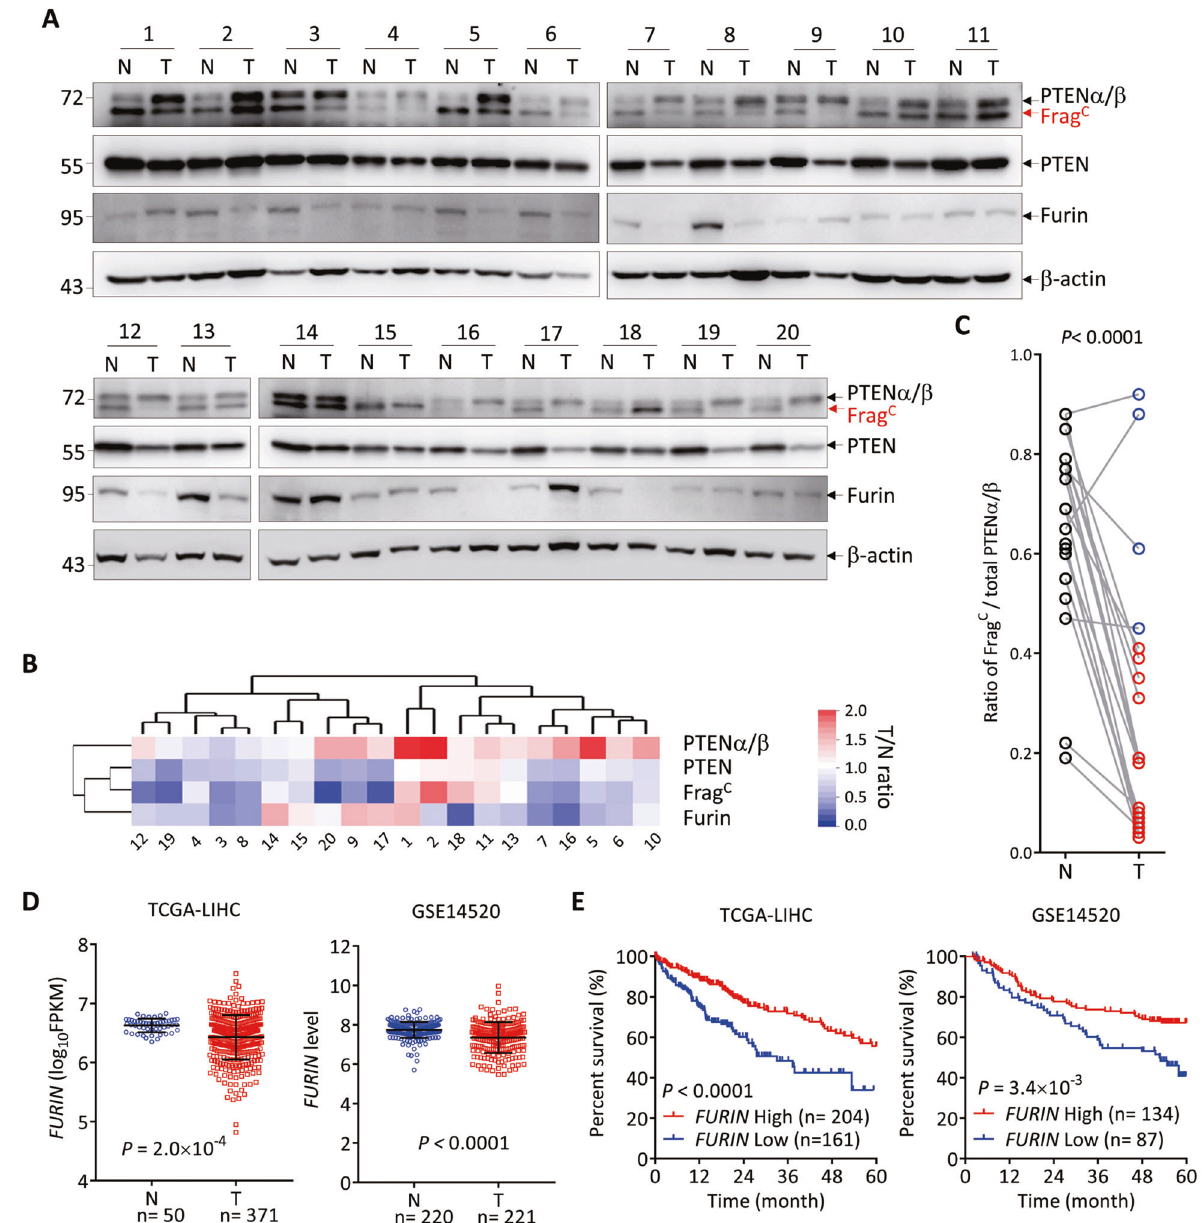
Fig. 6 Cleavage of PTEN α / β is inhibited in liver cancer tissues. A – C 20 liver cancer samples with paired tumor and normal tissues were subjected to Western blot analysis for the indicated proteins ( A ). The intensities of the blot bands were quanti fi ed by Image J, normalized to that of corresponding β -actin, and the T/N ratio of each protein for each patient was calculated and shown as a clustered heatmap ( B ). The ef fi ciency of PTEN α / β cleavage was calculated as the ratio of Frag C versus total PTEN α / β (Frag C + full-length PTEN α / β ) for each sample and compared between the tumor and normal tissue for each patient ( C ). Statistical signi fi cance was determined by two-tailed paired t -test with P values shown. D Scatterplot analysis of FURIN expression between tumor tissues and non-tumor tissues in TCGA LIHC and GEO GSE14520 data sets. Statistical signi fi cance was determined by Mann-Whitney U test (two-sided) with P values shown. E Kaplan-Meier plot of overall 5-year survival of patients with high or low expression of FURIN in the tumor tissues of TCGA LIHC and GEO GSE14520 data sets. Statistical signi fi cance was determined by Log-rank test growth and predicts a better postoperative disease-free survival in formation and progression of various malignancies including colon hepatocellular carcinoma [33]. carcinoma, head and neck cancers, lung, skin and brain tumors By focusing on the NTE-dependent processing of extracellular [31]. However, we found that Furin was downregulated in liver PTEN α / β , this study not only proposes a model that reconciles the cancer tissues compared to paired normal tissues and low FURIN paradoxical roles of extracellular and intracellular PTEN α in tumor- expression predicted poor prognosis of liver cancer patients. In igenesis, but also provides more precise guidelines for therapeutic agreement with our fi ndings, it has been reported that liver- uses of PTEN α as proposed previously [6], by revealing the tumor- speci fi c inactivation of Furin leads to increased hepatocellular suppressive role its C-terminal fragment in the extracellular space. carcinoma growth [32], and Furin overexpression suppresses tumor